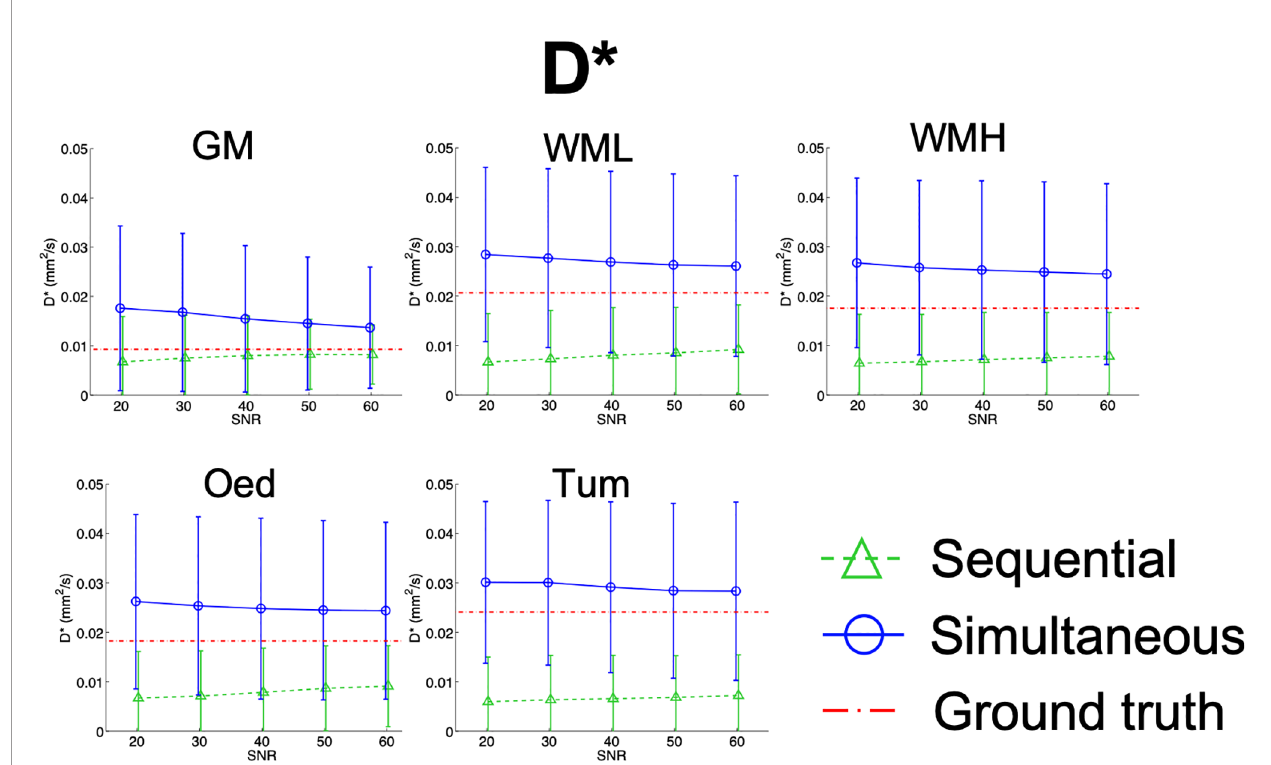
FIGURE 8 | Simulation results plots of D* in all tissues at all SNR levels. The geometric fi gures represent the mean and the vertical bars the standard deviation at each SNR